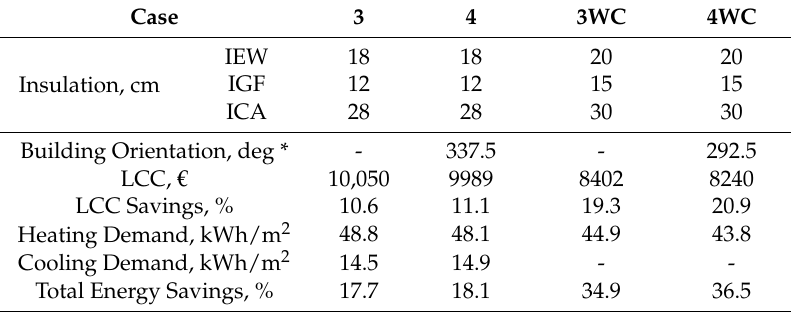
Table 9. Optimal results for cases 3 and